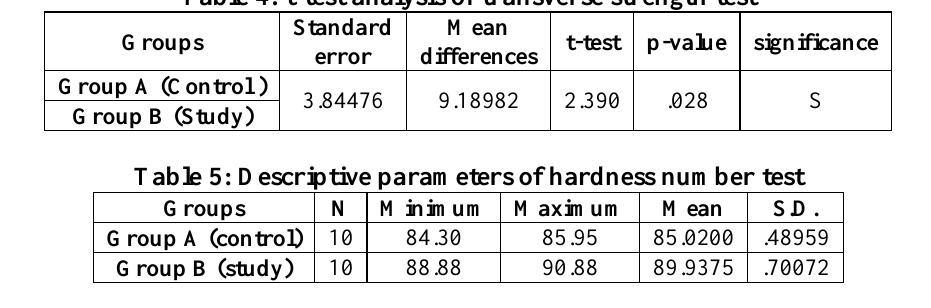
Table 6: t-test analysis of hardness number test